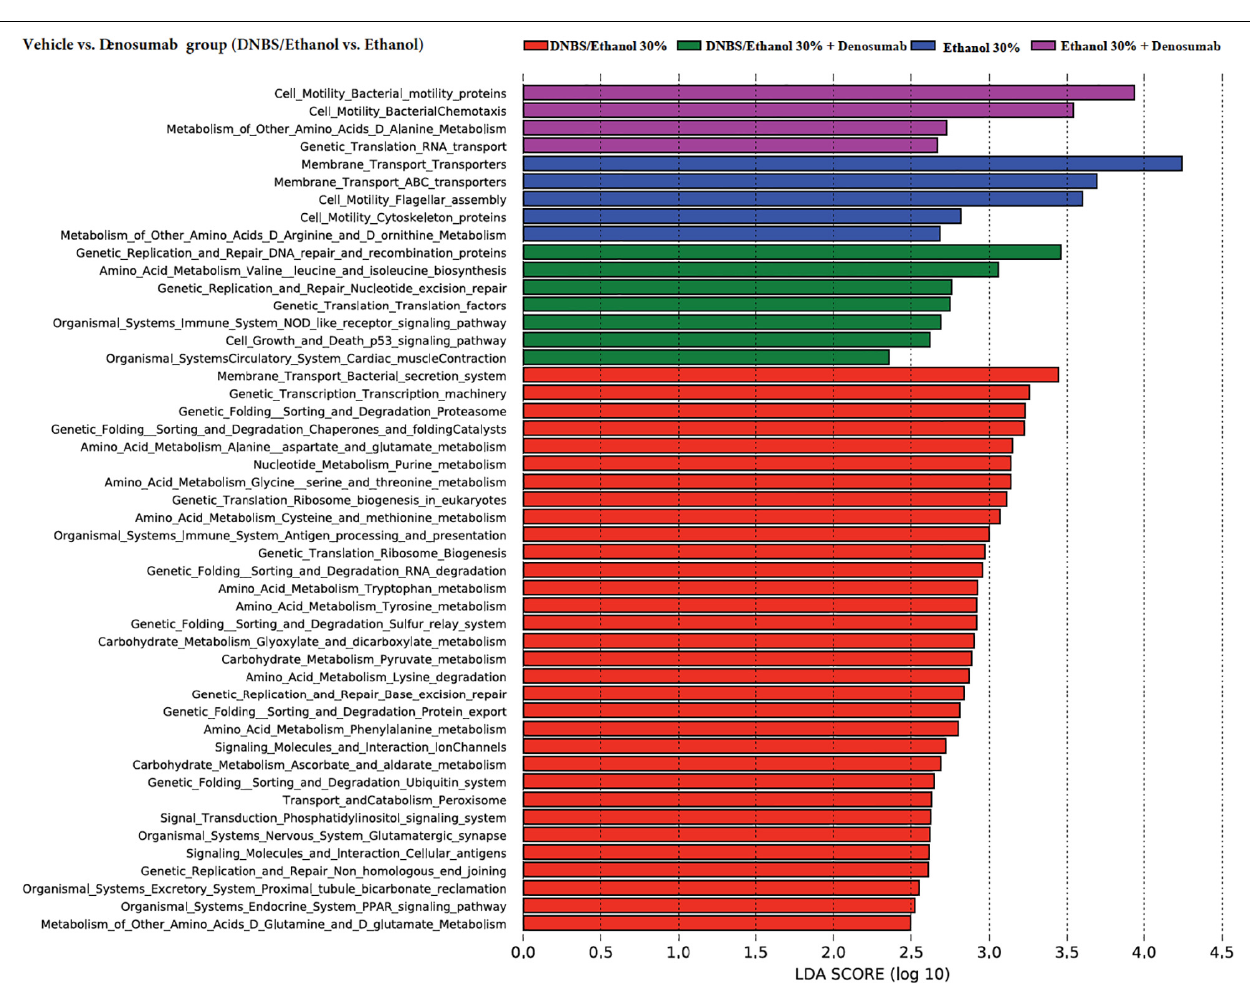
FIGURE 9 | Prediction of functional capacity of colon-associated microbiota in vehicle vs. denosumab-treated mice. A statistical difference between KEGG pathways (explored at Levels 1–3, indicated as L1–L3) of predicted colonic mucosa metagenomes were evaluated by LEfSe, a metagenome analysis approach which performed the linear discriminant analysis following the Wilcoxon Mann–Whitney test to assess effect size of each differentially abundant variable. The length of the horizontal bars indicated log-fold changes for each variable. Color code represents the class of treatments; red and green represent colitic condition of DNBS/Ethanol, while blue and purple are showing the Ethanol 30% condition in the absence and presence of denosumab,